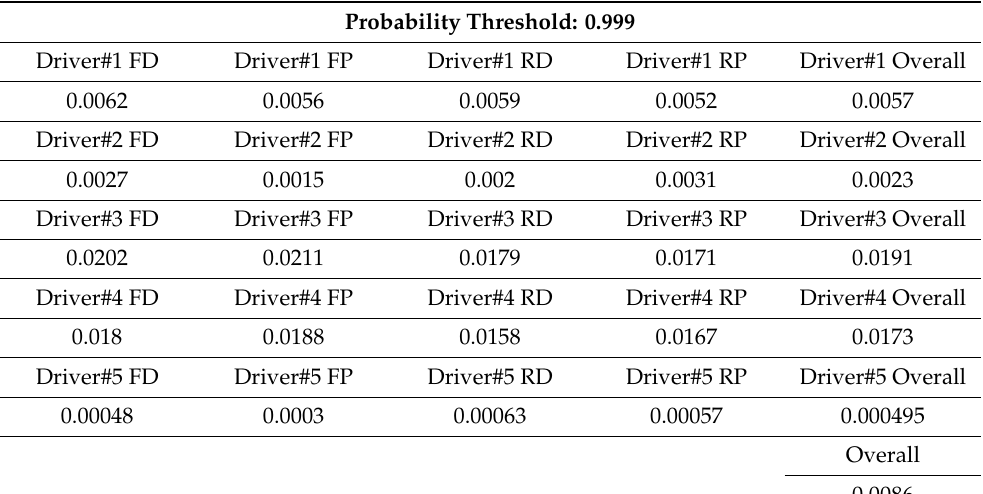
Table 8. Mean square error for each driver, each driver’s individual brakes, and overall values with probability threshold at 0.999.